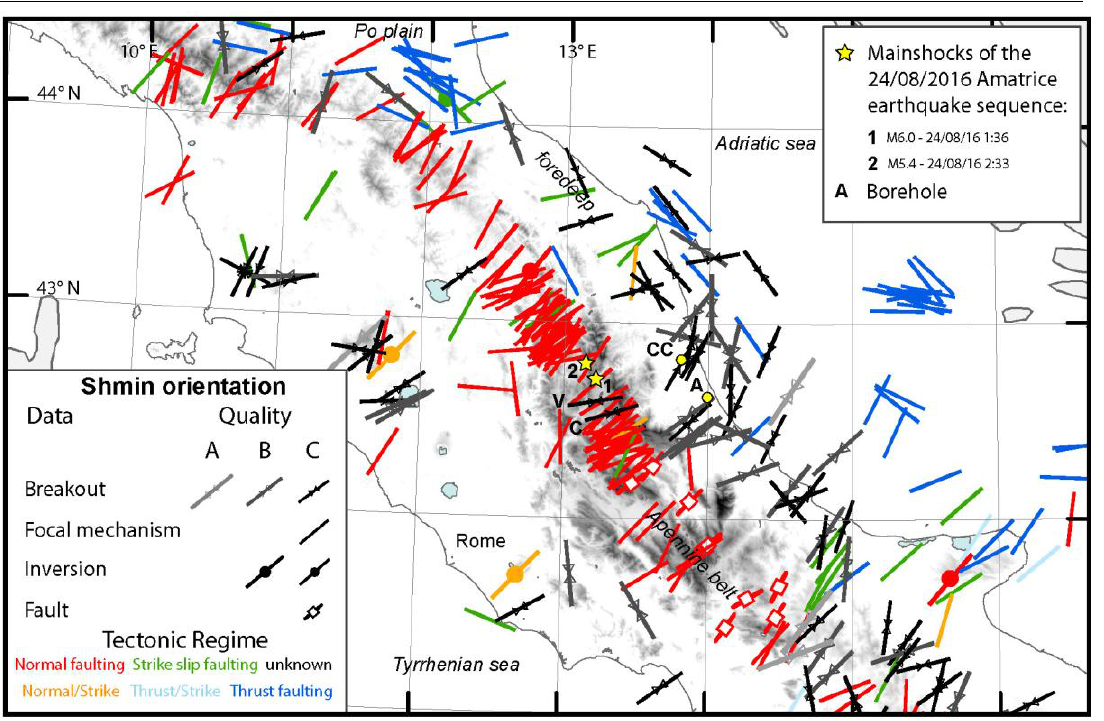
Figure 1. Present-day stress in central Italy. Minimum horizontal stress (Shmin) orientations [Montone and Mariucci, 2016) and the two mainshocks of the Amatrice seismic sequence until October 3 rd , 2016 [BSI, 2016]. Normal faulting regime: Shmin=sigma 3; Strike-slip: Shmin= sigma 3; Thrust: Shmin= sigma 2. Location of the boreholes analysed in this study: A, Atri; CC, Colle Casone; C. Campotosto; V,